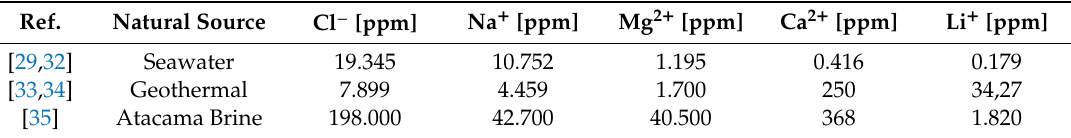
Table 1. Main ion compositions of natural